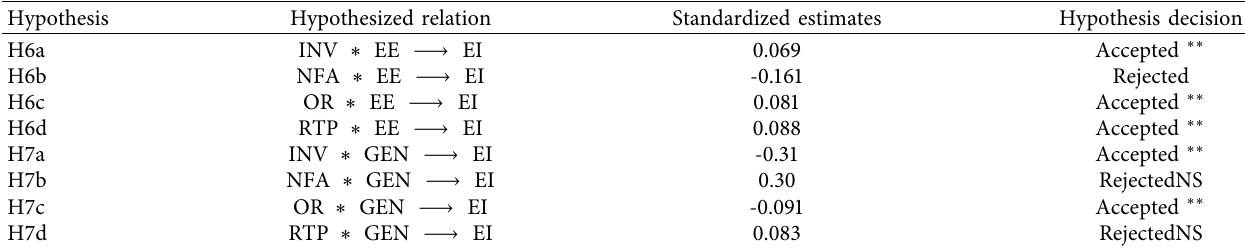
Table 8: Moderation effect (hypotheses testing of H6, and